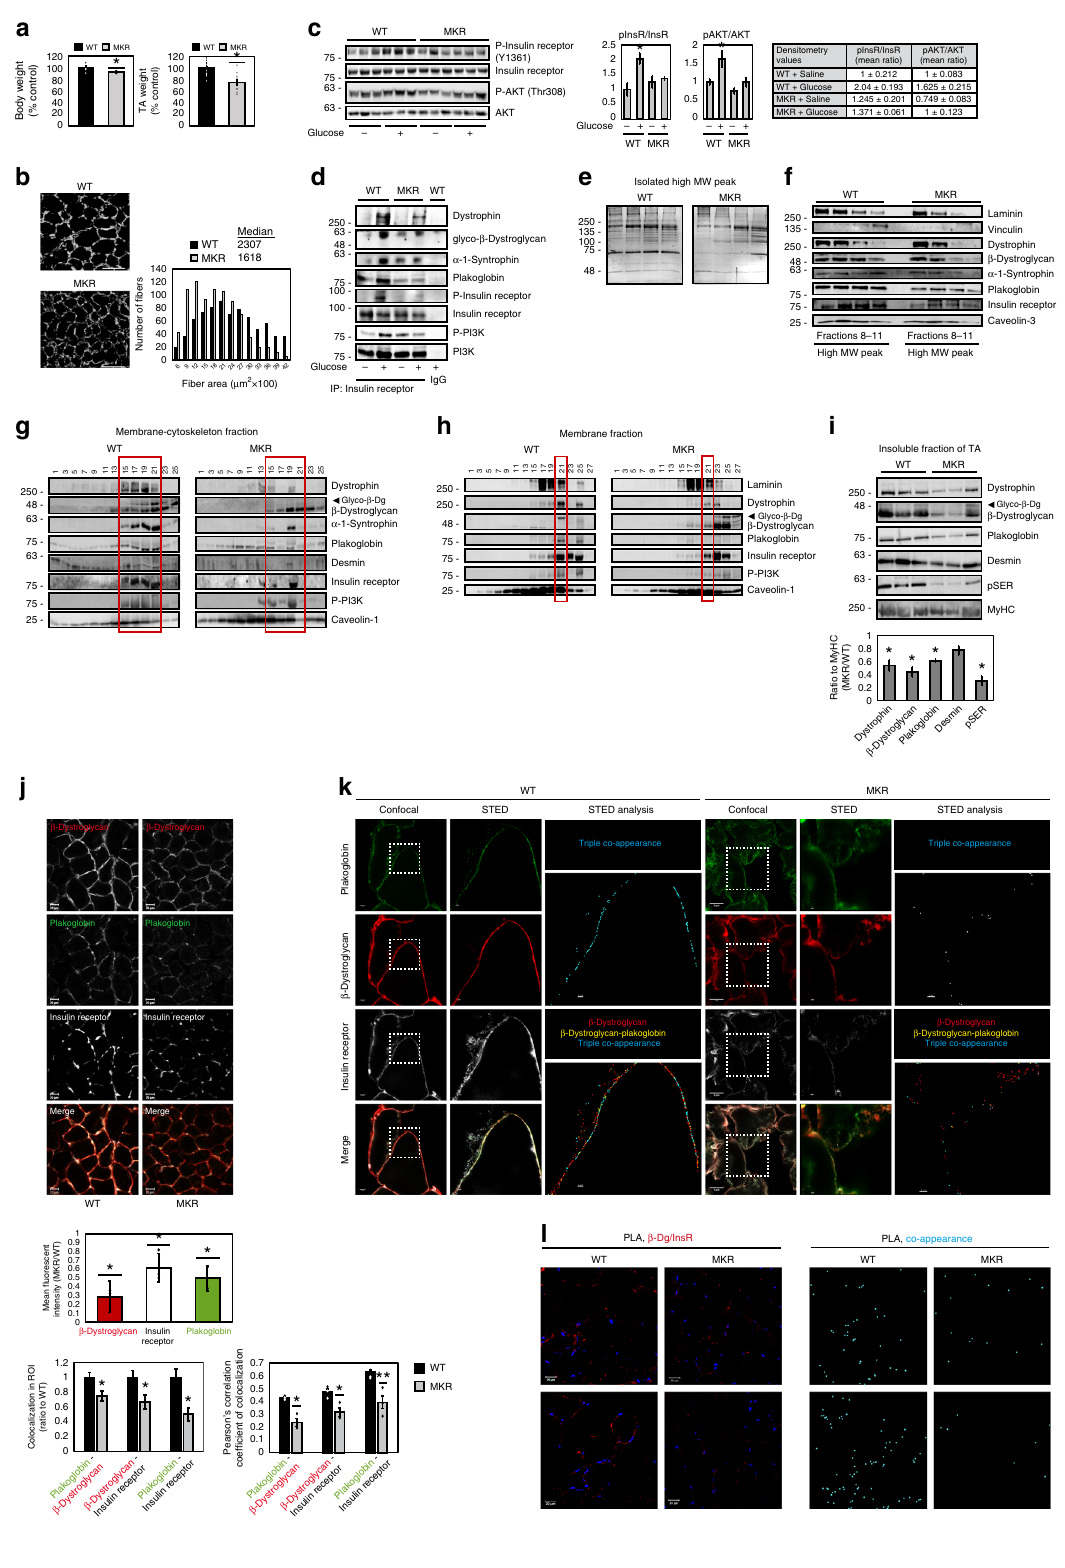
the critical domains in plakoglobin that are required for its het- erodimerization with DGC and the insulin receptor, we generated 6His-V5-tagged truncation mutants of plakoglobin lacking the N-terminal ( Δ N), the C-terminal ( Δ C), or either end ( Δ NC) domains, while leaving the central armadillo domain intact